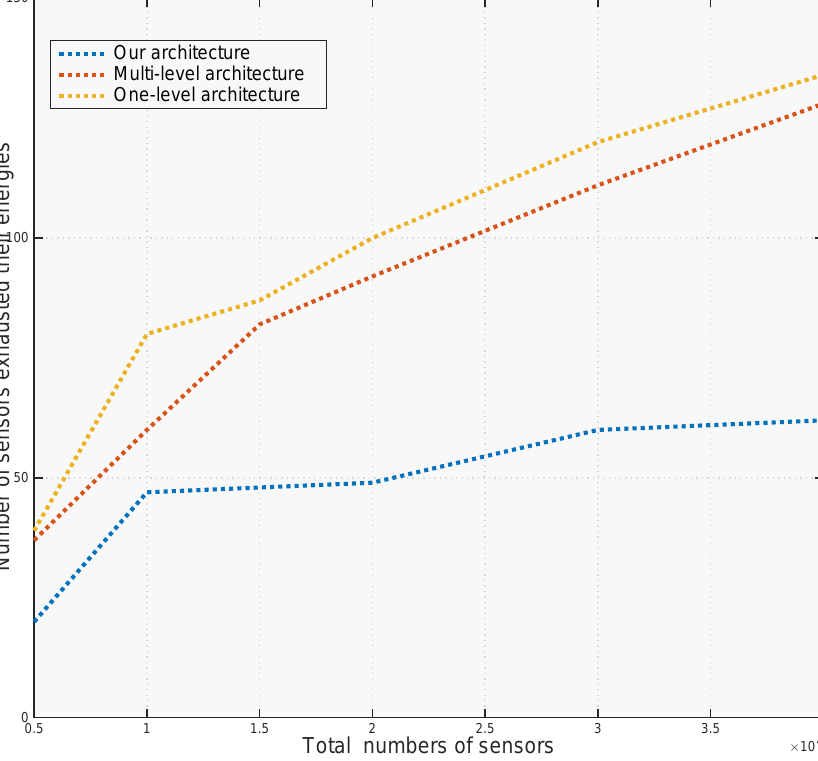
Figure 12. Number of sensors having exhausted their energies at the end of the simulation according to